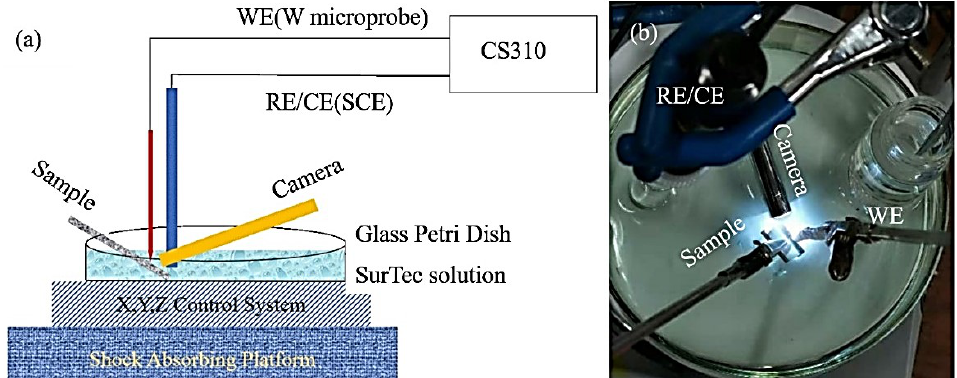
Figure 1. ( a ) Schematic explanation of the pH investigation at the solution – metal interface employed two-electrode system, where the red arrow outlins the well-prepared tungsten-tip microelectrode; ( b ) The image of the experimental set-up and SCE electrode with the reference and counter electrode (RE/CE) and tungsten microelectrode as the working electrode (WE).